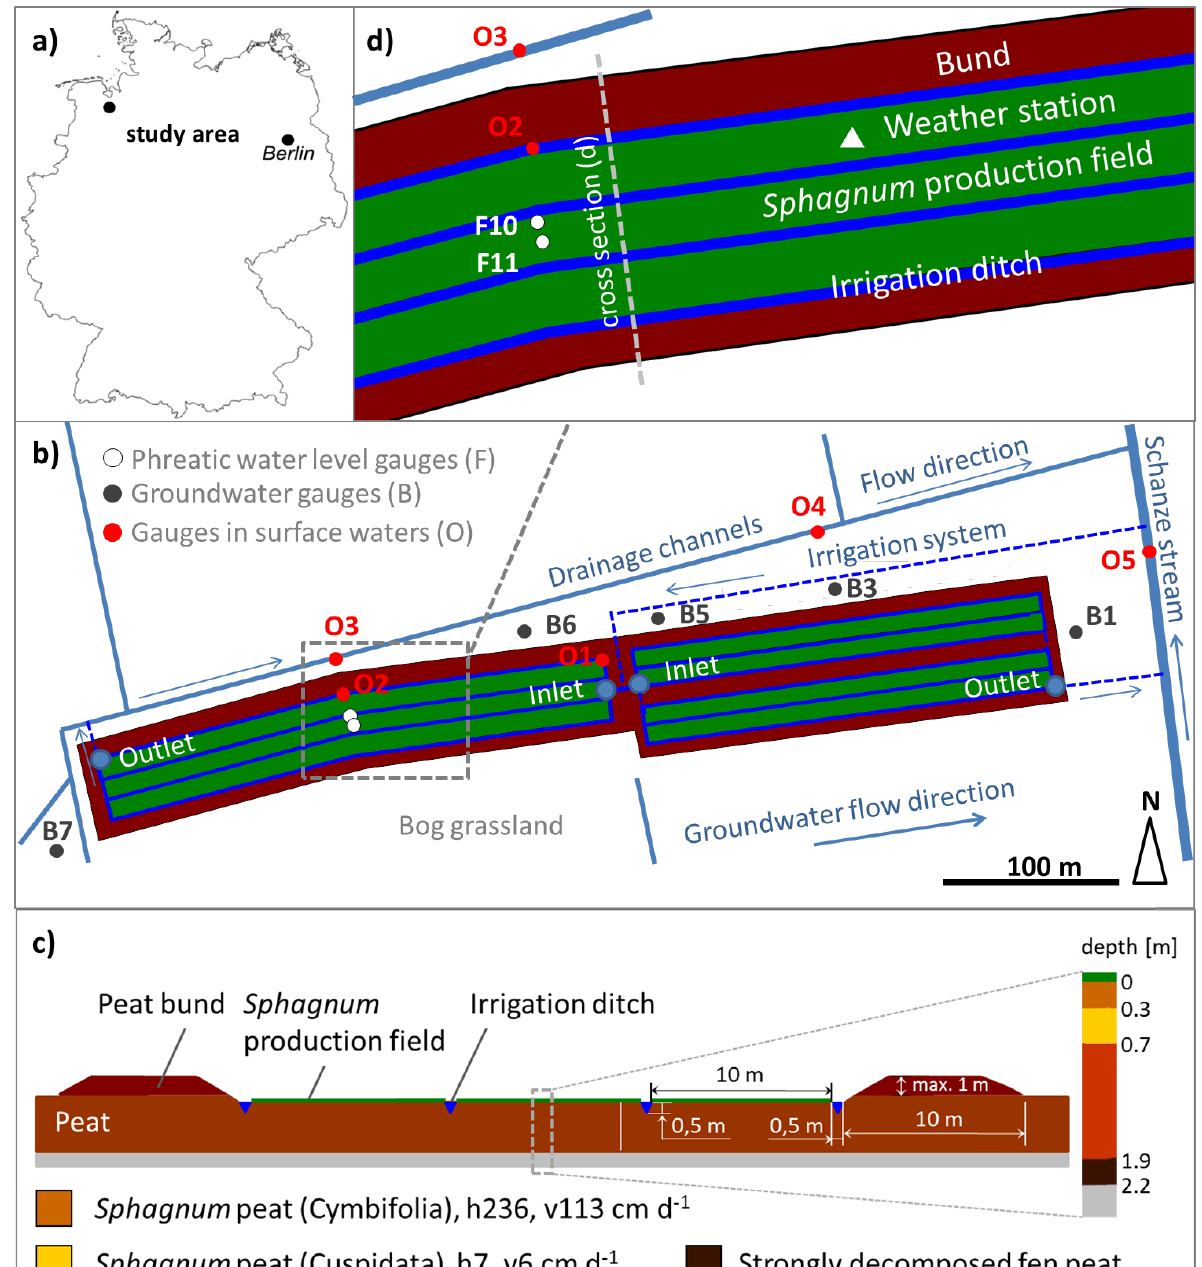
Figure 1. The study area on Hankhauser Moor: a) location in north-west Germany; (b) full extent of the Sphagnum farming site and surrounding bog grassland with irrigation system; (c) cross-section of the Sphagnum farming trial, which consists of three Sphagnum production fields (10 m wide, 275 m long) and four irrigation ditches surrounded by the bund of the western water regulation system, with a profile showing the stratigraphical sequence of peat layers (Krebs et al . unpublished data) and their saturated hydraulic conductivities (prefixed h for horizontal and v for vertical, in cm d -1 , Rosskopf et al . 2016); and d) part of the Sphagnum farming trial. The positions of the weather station (white triangle) and water level gauges (white circles: phreatic, black circles: groundwater, red circles: surface water) are